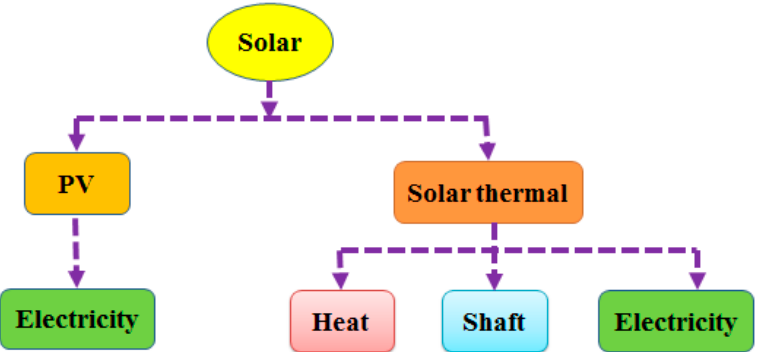
Figure 9. Pathways for solar energy utilization in wastewater treatment plants.